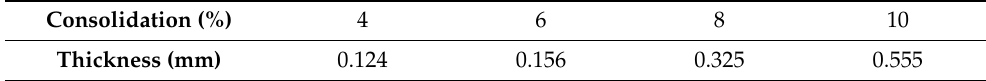
Table 3. The thickness of W-OH solid consolidations using different concentrations.